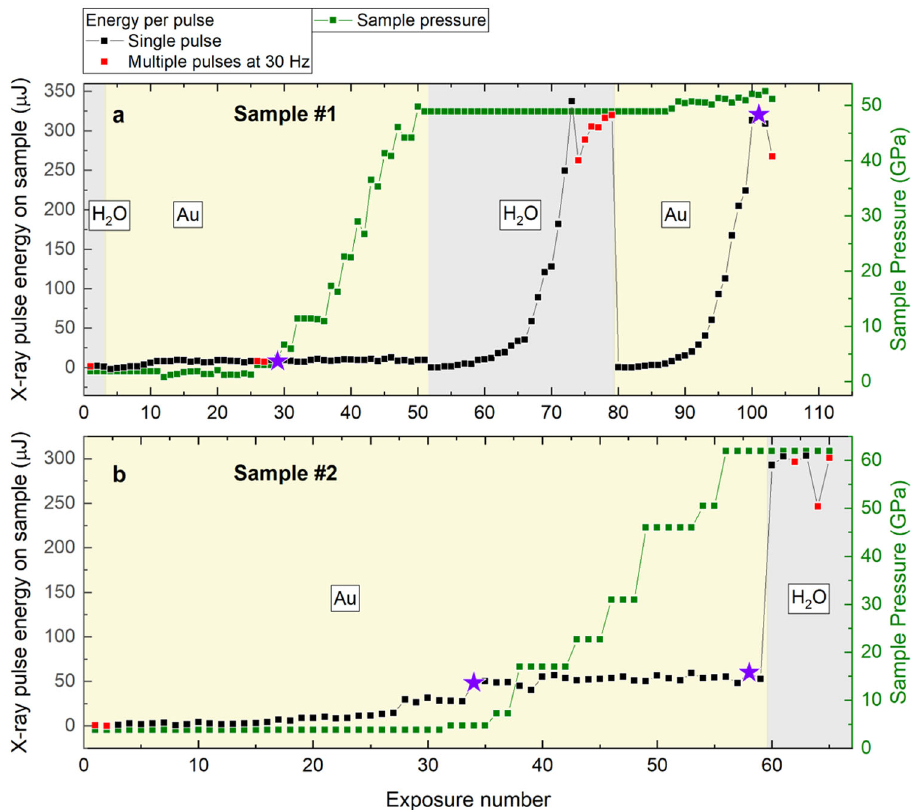
Fig. 3 X-ray exposure history and sample pressure during the PAL-XFEL experiment for samples #1 and #2. The shaded areas indicate whether the X- ray beam was focused on the H 2 O (gray) or Au foil (yellow) in ( a ) sample #1 and ( b ) sample #2. The X-ray pulse energy incident on the sample is corrected to account for absorption of the upstream diamond anvil. The pressure was determined from the peak position of the (111) Au re fl ection, as described in the text. For exposures in which the Au re fl ection was not visible (i.e., when targeting the H 2 O), the pressure was assumed to be the same as the previous or subsequent exposure at the same membrane pressure. The purple stars indicate the experimental conditions for which temperature calculations were performed (Supplementary Fig.